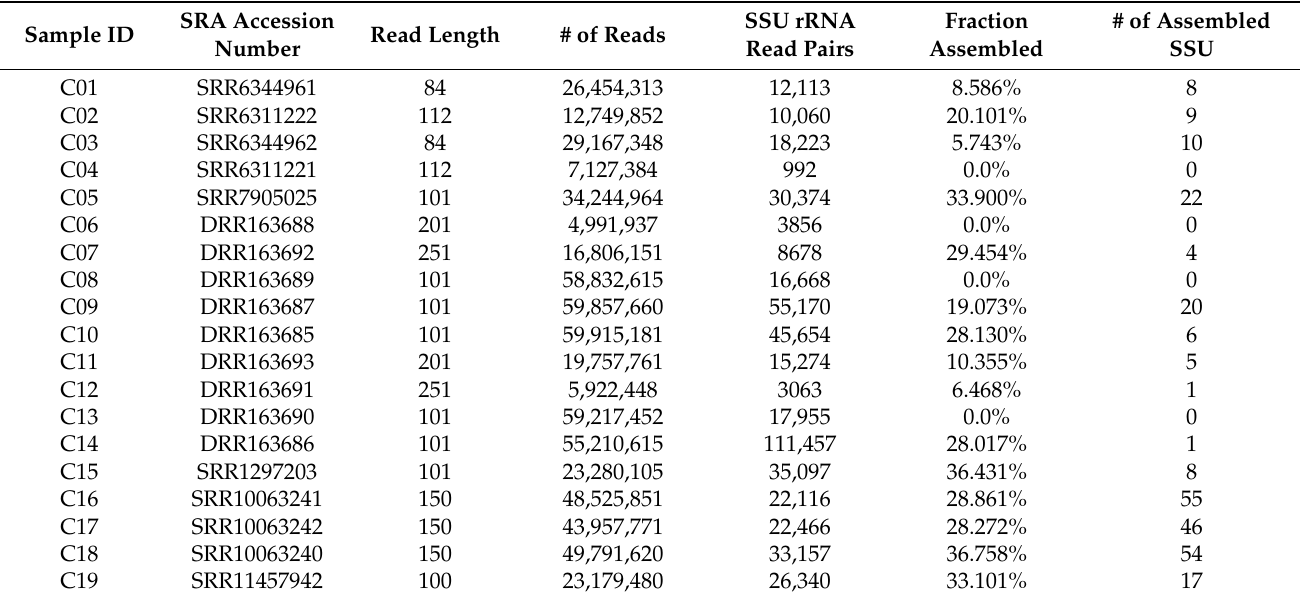
Table 2. Metagenomic data extracted from the NCBI SRA and information on the number of extracted reads and assembled SSU